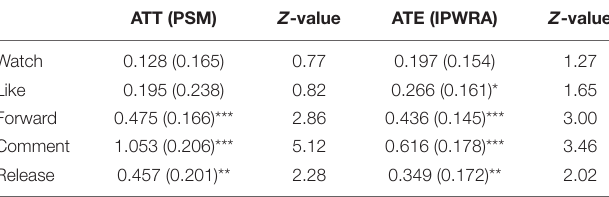
TABLE 7 | Robustness check by using PSM approach and IPWRA estimator.